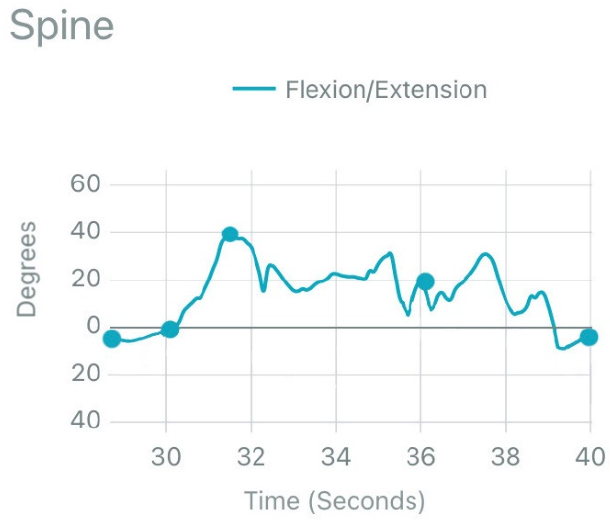
Figure 2. Biomechanical behavior of lumbar spine in the sagittal plane during stand up followed by ten steps walking in the calibration procedure.